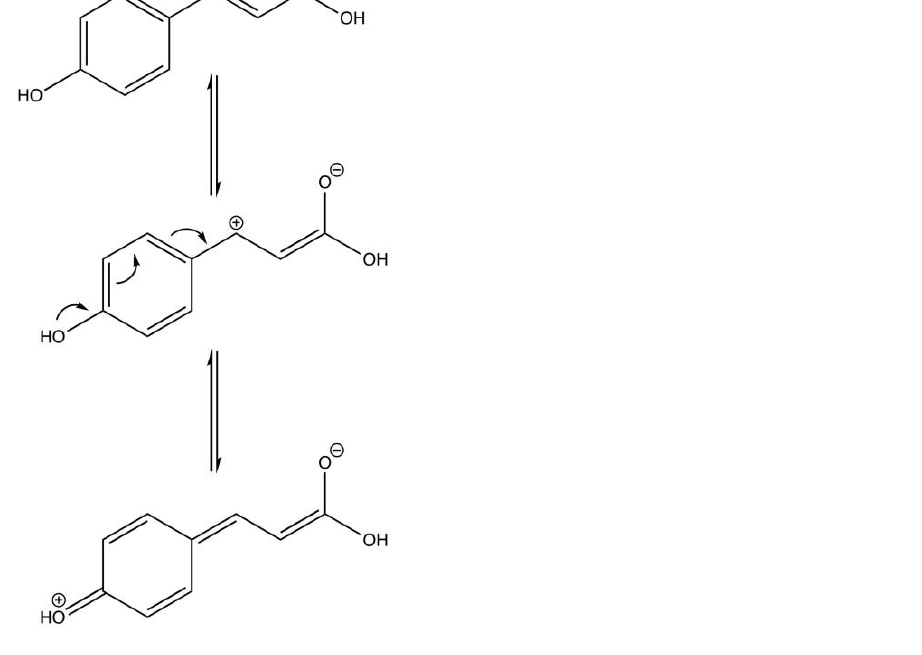
Figure 4. Resonance effect of the aromatic ring on trans -cinnamic acid to activate the β -position of the trans - p -hydroxycinnamic acid for the 1,4-nucleophilic addition.